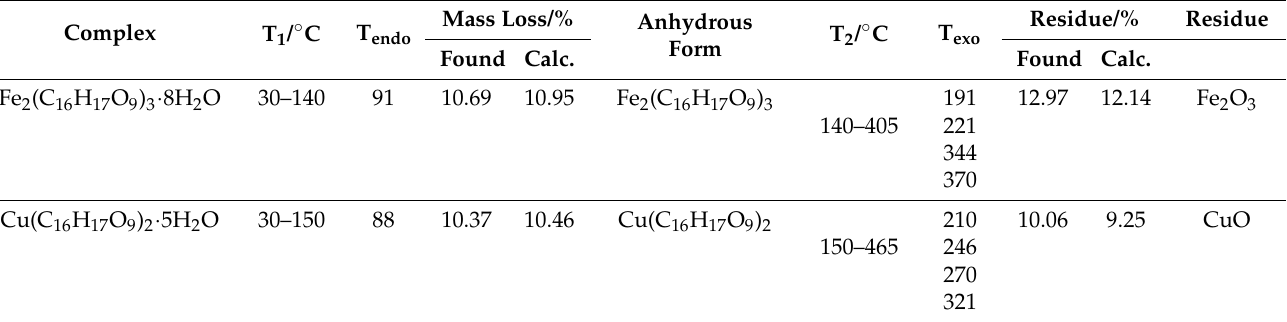
Table 2. Elemental analysis of Cu(II) and Fe(III) complexes with chlorogenic acid. Compound